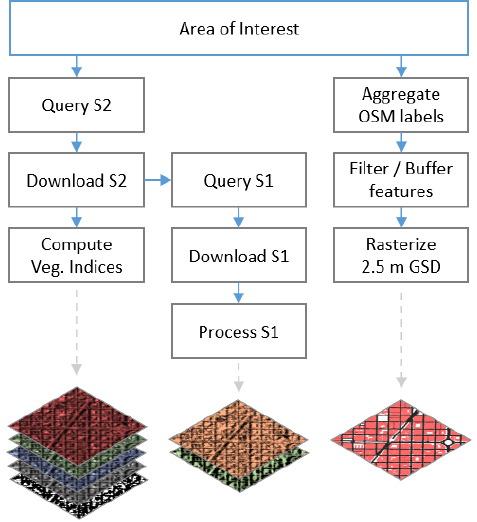
Figure 3. dataset generation pipeline for a generic area of interest.